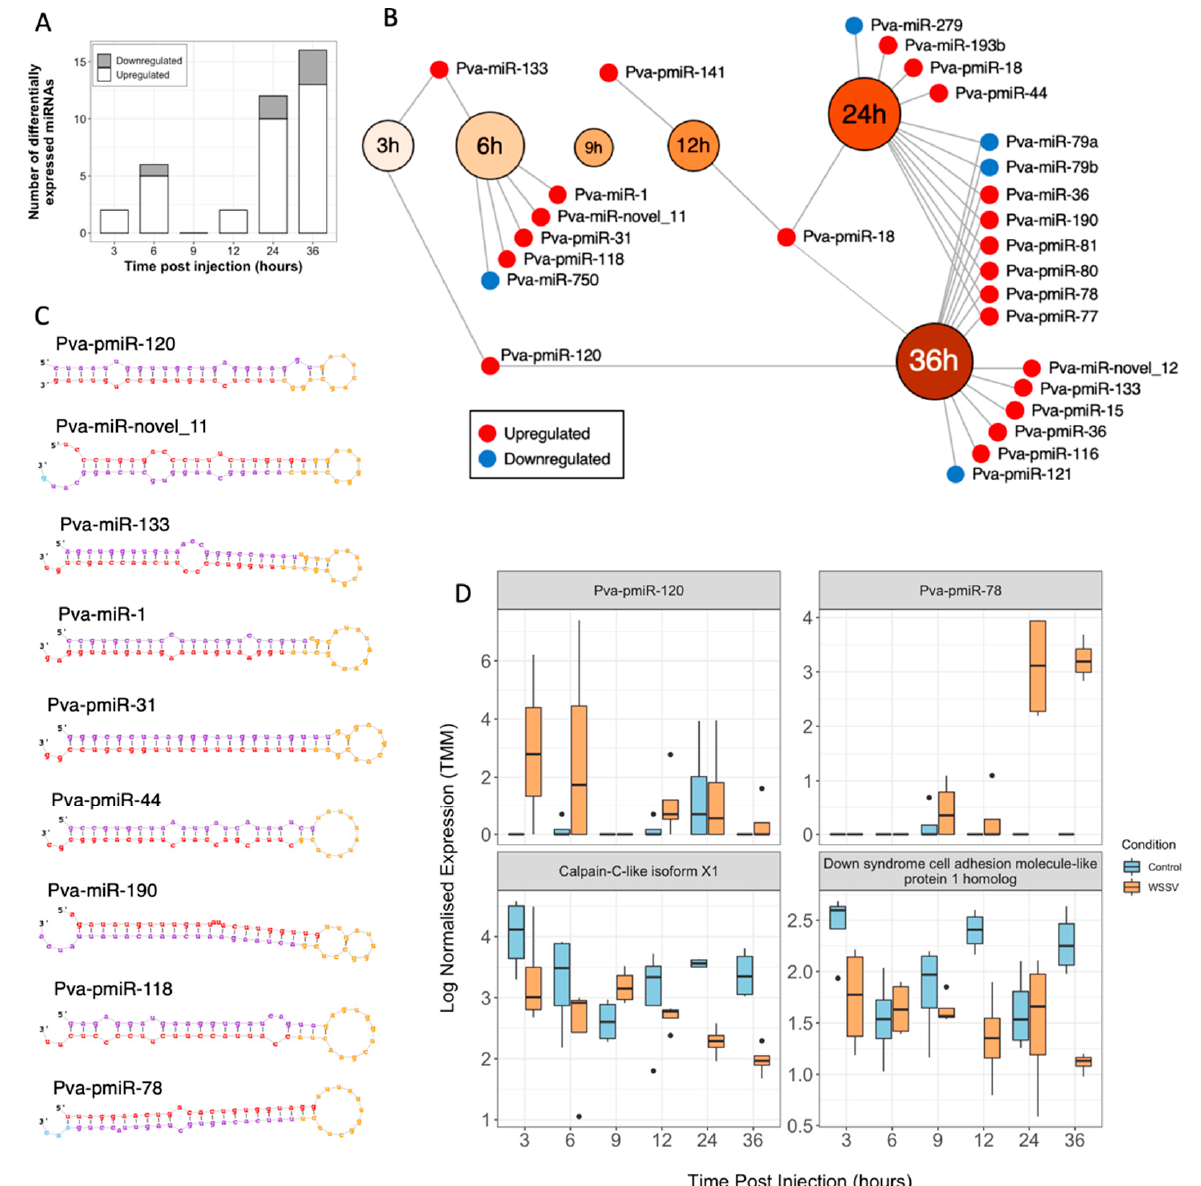
Figure 4. miRNA-seq results. ( A ) Stacked bar plot displaying the number of significantly differentially expressed miRNAs at each timepoint following WSSV injection. ( B ) Venn diagram depicting the overlap in differentially expressed miRNAs between the timepoints sampled following WSSV injection. ( C ) RNAfold structure of the miRNAs discussed herein. Red nucleotides depict the mature miRNA sequence, yellow nucleotides correspond to the characteristic hairpin loop of miRNA precursors and purple nucleotides depict the star miRNA sequence. ( D ) Boxplots displaying the temporal transcription patterns of novel shrimp miRNA Pva-pmiR-120, which is significantly upregulated at 3 hpi, and its predicted target calpain-C-like isoform X1, which is subsequently downregulated. In addition, a boxplot of novel shrimp miRNA Pva-pmiR-78, which is significantly upregulated at 24 and 36 hpi, and its predicted target down syndrome cell adhesion molecular-like protein 1 homolog, which is concomitantly downregulated.